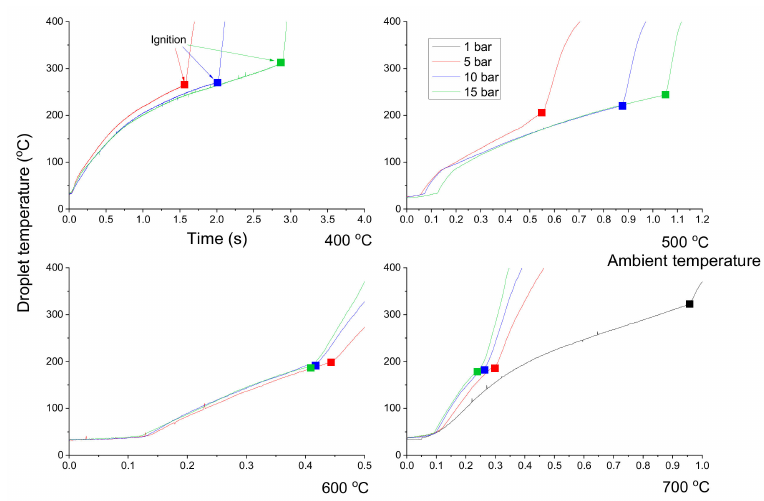
Figure 7. Temperature variation in a diesel droplet at various ambient temperatures and pressure.